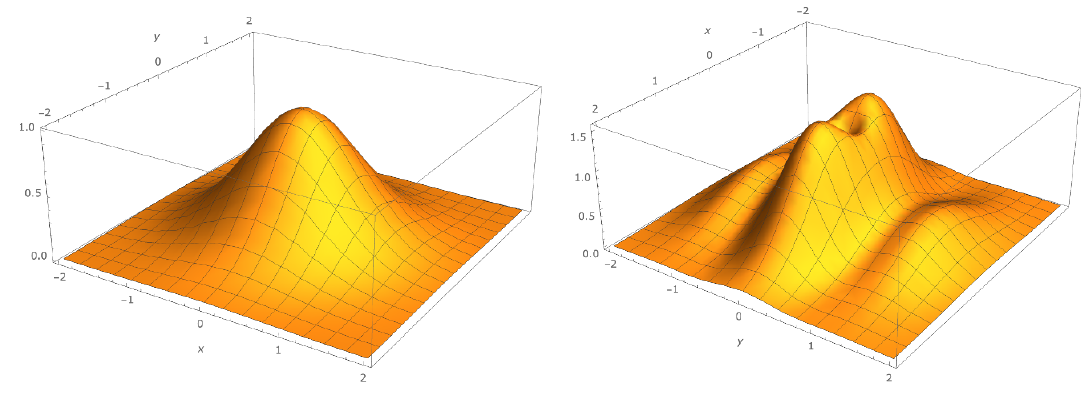
Figure 12. 3D-plot of the analytical distributions occuring in the validation